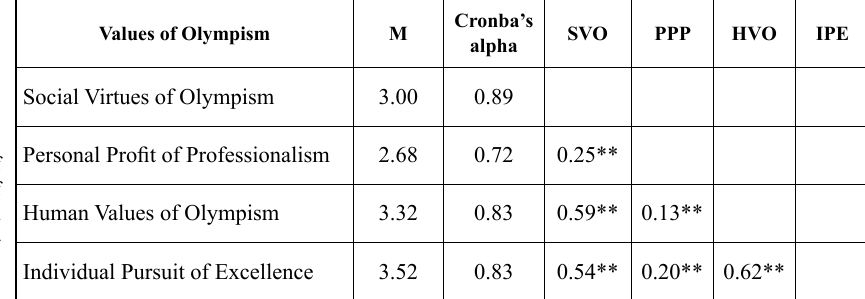
Table 1. Correlation and des- criptive statistics of Olympsim values scale